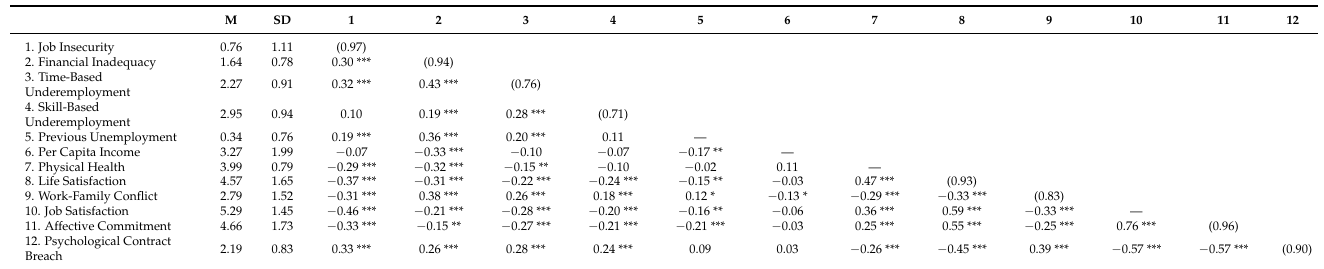
Table 2. Descriptive statistics, correlations, and reliability.